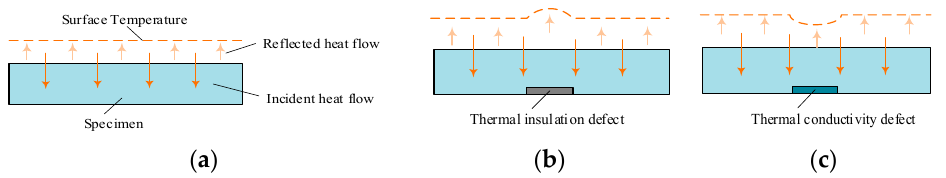
Figure 1. Surface temperature and heat flow diffusion under different conditions: ( a ) specimen with no defect; ( b ) specimen with thermal insulation defect; ( c ) specimen with thermal conductivity defect.